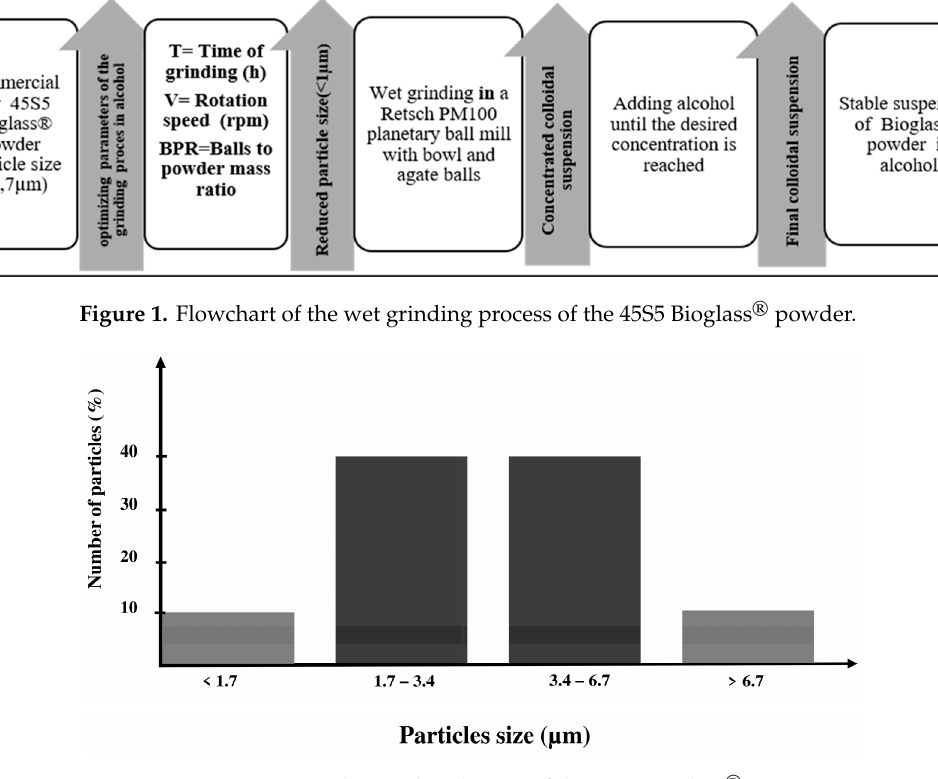
Figure 2. Particle size distribution of the 45S5 Bioglass ® .